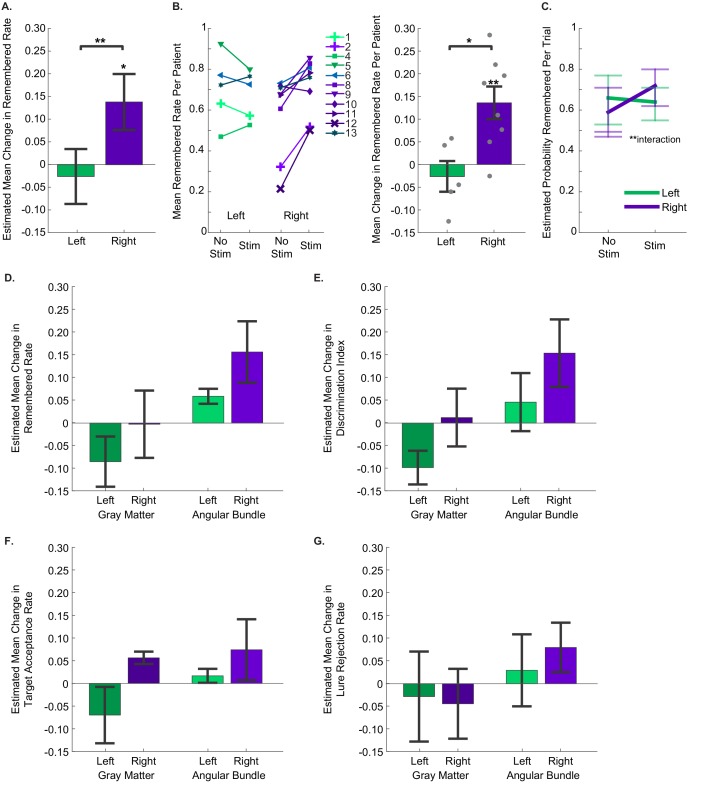
Effects of stimulation in the entorhinal area, proper.Sessions when the stimulating electrode was located in the subiculum are excluded. The layout of A-C is as in Figure 3. (A) The effect of stimulation hemisphere was significant (p=2.69 × 10−4, N = 30 sessions from 11 participants (left: 14 sessions from five participants; right: 16 sessions from eight participants)). (B) Difference in remembered rates for left and right entorhinal area stimulation were significantly different (t(11) = −3.05, p=0.011), and stimulation in the right entorhinal area leads to significantly positive changes in remembering (t(7) = 3.79, p=0.007). (C) The interaction term between stimulation condition and hemisphere was significant (p=0.002, N = 983 trials from 11 participants), along with whether the target was presented before the lure (p=2.31×10-4; EM (target first): 0.71. EM (lure first): 0.59). (D–G) The estimated mean difference in stimulated compared to non-stimulated trials in (D) remembered rate, (E) discrimination index, (F) target acceptance rate, and (G) lure rejection rate. The main effects of stimulation hemisphere and stimulation region were significant for all behavioral metrics except lure rejection rate, with stimulation in the right hemisphere and in the angular bundle improving performance and stimulation in the left entorhinal gray matter impairing performance for each (remembered rate: hemisphere: p=1.36 × 10−7, region: p=0.0034; DI: hemisphere: p=2.52 × 10−6, region: p=1.89 × 10−3; target acceptance rate: hemisphere: p=0.021, region: p=2.70×10−4); In the case of lure rejection rate, only stimulation hemisphere was significant. (hemisphere: p=0.010; region: p=0.718). Error bars are 95% Wald Confidence Intervals.